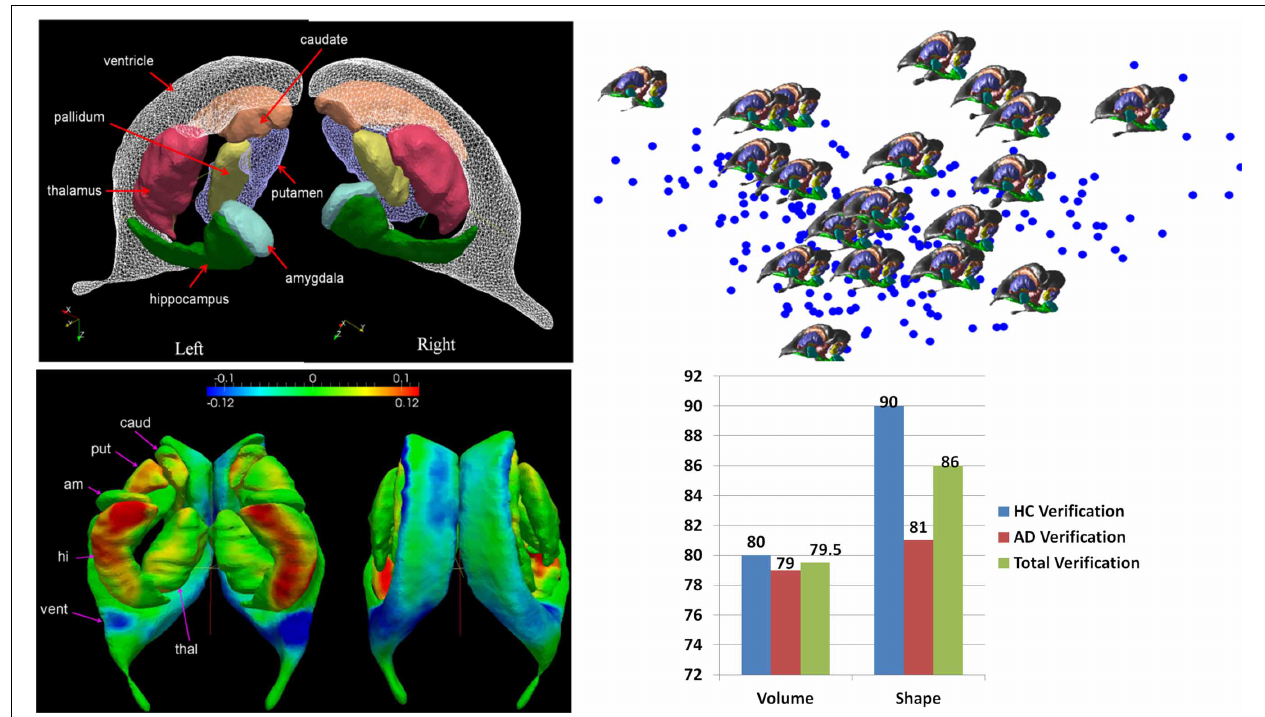
FIGURE 5 | Top row: Panel shows the left-right subcortical structures for human at 1mm including amygdala (A, light blue), caudate (C), hippocampus (H, green), globus pallidus (PAL), putamen (PUT), ventricle (VL), thalamus (TH). The right panels shows the layout in the geodesic coordinate system of 250 of the anatomies (blue dots) in the first two dimensions with 20 of the brains shown explicitly with the basis dimensions on the order of 20–40 dimensions for each subcortical structure occupying 95% of the variatiance of anatomical variation with ordering A20 < PAL22 < C25 < PUT27,VL27 < H30 < THA40. Bottom row : Shows the geodesic coordinates of the population (top right) relative to the atlas (top left) shown as a shape statistic computed by averaging over all geodesic mappings and computing the Jacobian of the